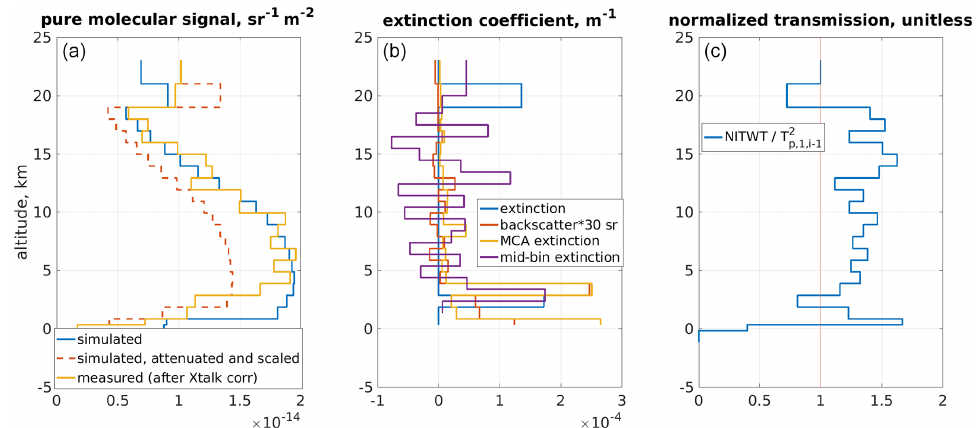
Figure 10. Illustration of how extinction overestimation in a given bin leads to errors in bins below. The left panel (a) shows observed signals (yellow), simulated signals (blue) and simulated signals with extinction from particles down to the previous bin and normalized by the first bin (dashed red). The extinctions retrieved by several means are shown in the middle panel (b) (SCA in blue, derived from SCA backscatter with an arbitrary lidar ratio of 30sr in red, from the MCA in red and the mid-bin SCA in purple). The value from which the extinction is derived is shown in the right panel (c)